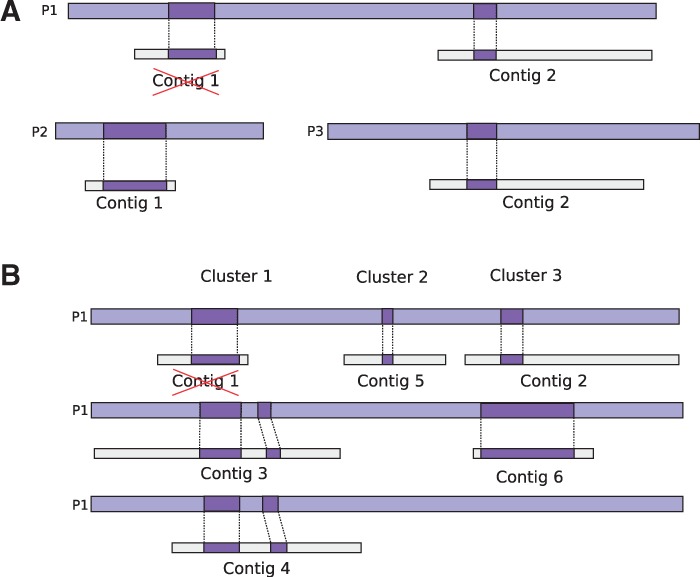
(A) Although contig 1 and 2 are mapped to
protein P1, they have better mappings on protein P2 and P3, respectively. The
similarity score between contig 1 and P1 is lower than α = 0.75 times
the similarity score between contig 1 and P2, and is removed from P1. The similarity
score between contig 2 and P1 is within α of the similarity score between
contig 2 and P3, and both mappings are kept. (B) Contigs with
similarity to the P1 are clustered according to the region of similarity. Here,
contigs 3 and 4 are clustered together in contig cluster 1, contig 5 is the only
contig in contig cluster 2, and contig 2 and 6 are clustered in contig cluster
3